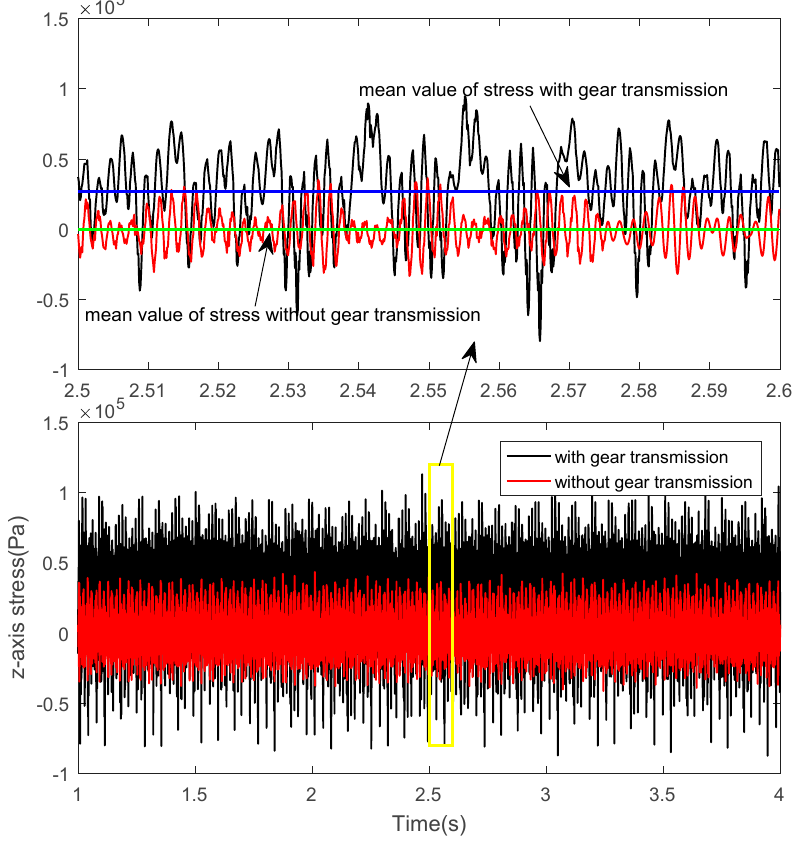
Figure 15. Effect of gear meshing on the stress of the gearbox housing.